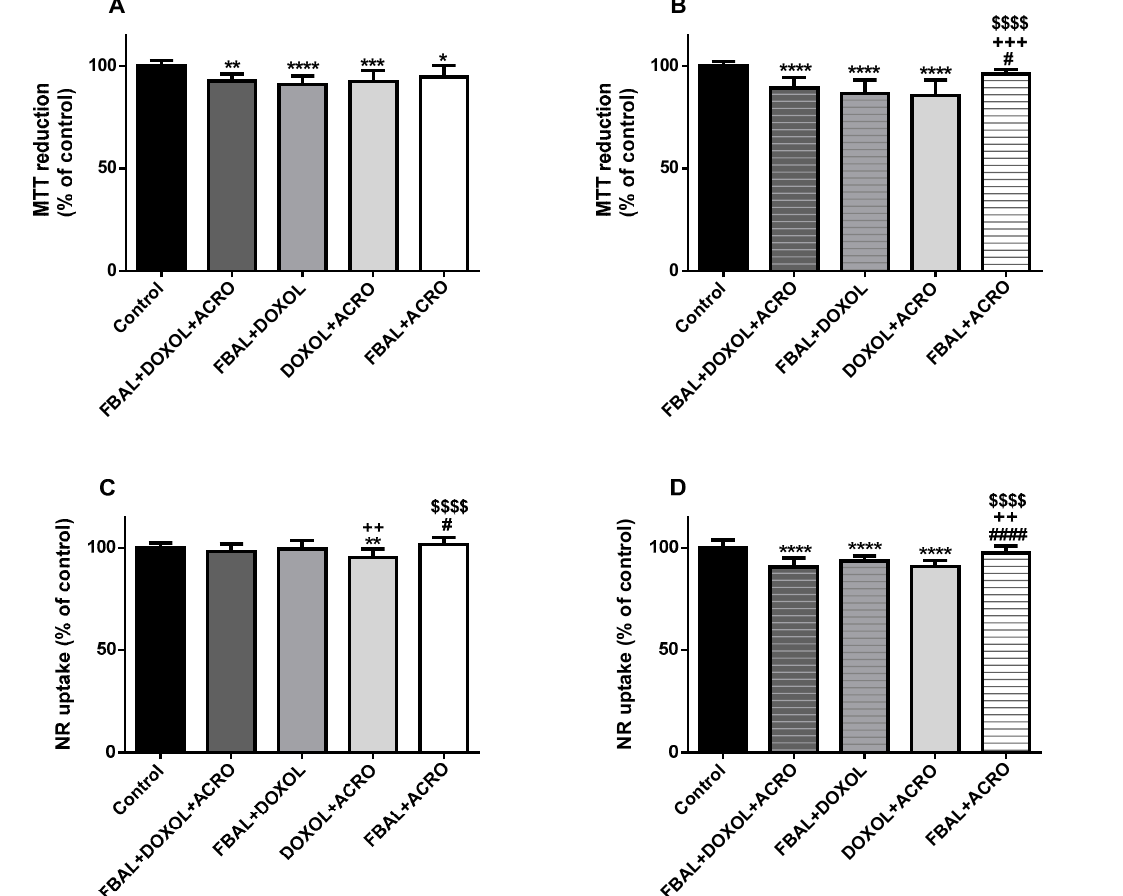
Figure 7. Cytotoxicity evaluated by ( A , B ) the MTT reduction assay and the ( C , D ) NR uptake assay in differentiated H9c2 cells incubated with the combination of metabolites (DOXOL + FBAL + ACRO) for 48 h. ( A , C ): FBAL 50 μ M + DOXOL 0.2 μ M + ACRO 1 μ M. ( B , D ): FBAL 100 μ M + DOXOL 1 μ M +